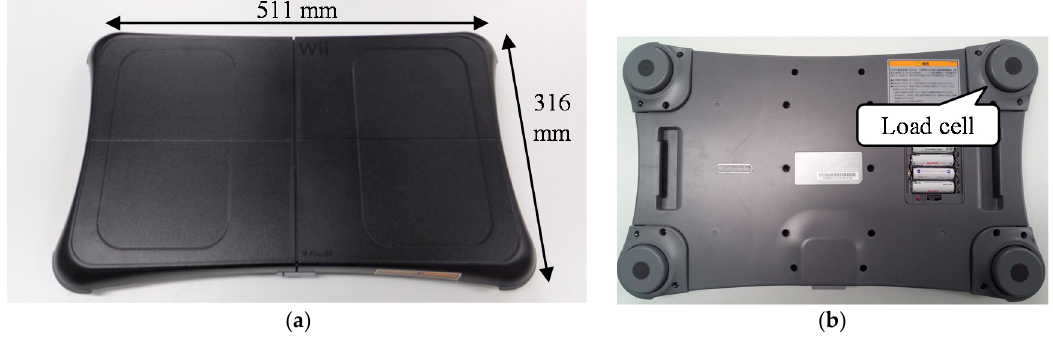
Figure 1. Appearance of the Nintendo Wii Balance Board (WBB): ( a ) usable surface of the device, and ( b ) four load cells of the WBB located near the four corners (bottom view of the device). The devices were connected to a laptop computer using custom software (C++), and data was collected through a Bluetooth connection. The vertical force data from each of the four force sensors, as well as the total vertical force value, were acquired at 100 Hz. The WBBs were placed upon two laboratory-grade force plates (Type 9281E, Kistler, Winterthur, Switzerland) with surfaces of 400 mm × 600 mm in area, which were mounted on the laboratory floor, as shown in Figure 2a. The force plates were operated using a motion capture system (VICON, Oxford, UK), and the data from them contained GRF and COP measurements in the x and y directions, which were obtained at 1000 Hz.